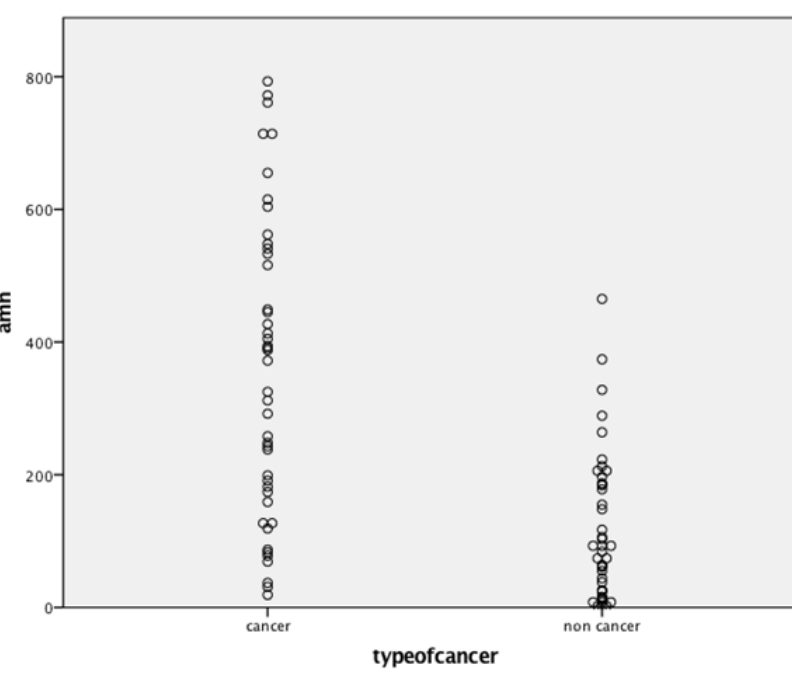
model ; p < 0.62) 20 . Bleil et al . found there was a